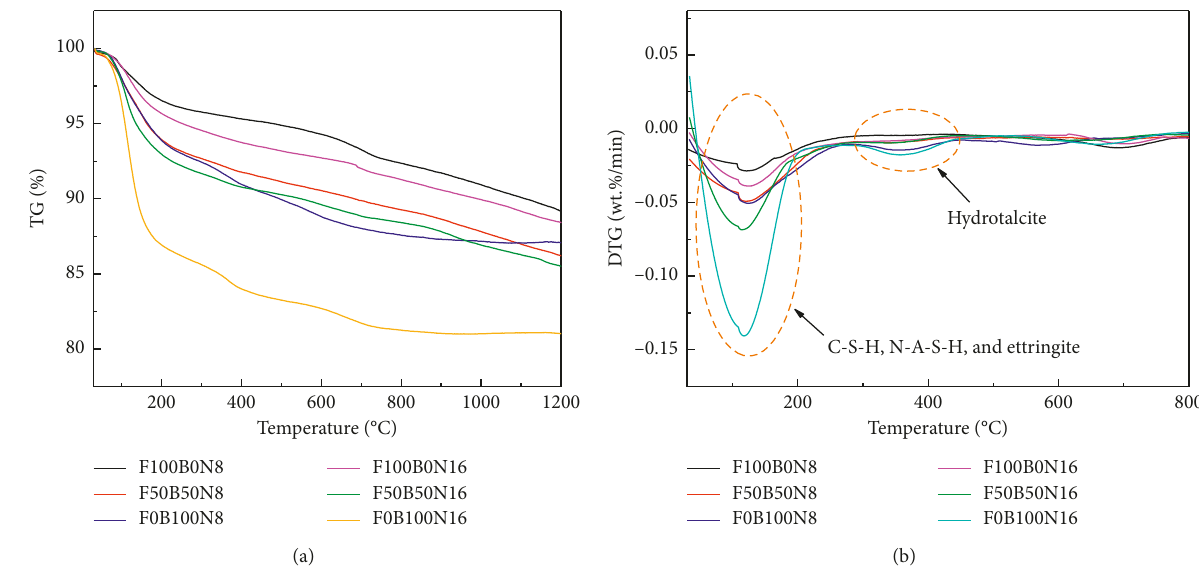
Figure 4: (a) TG curve; (b) DTG curve.